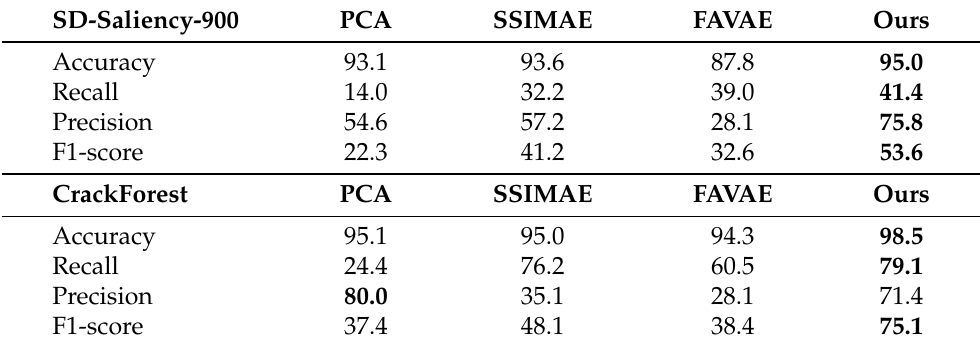
Table 1. Quantitative pixel-level defect detection results among unsupervised approaches. The best results are highlighted in bold.